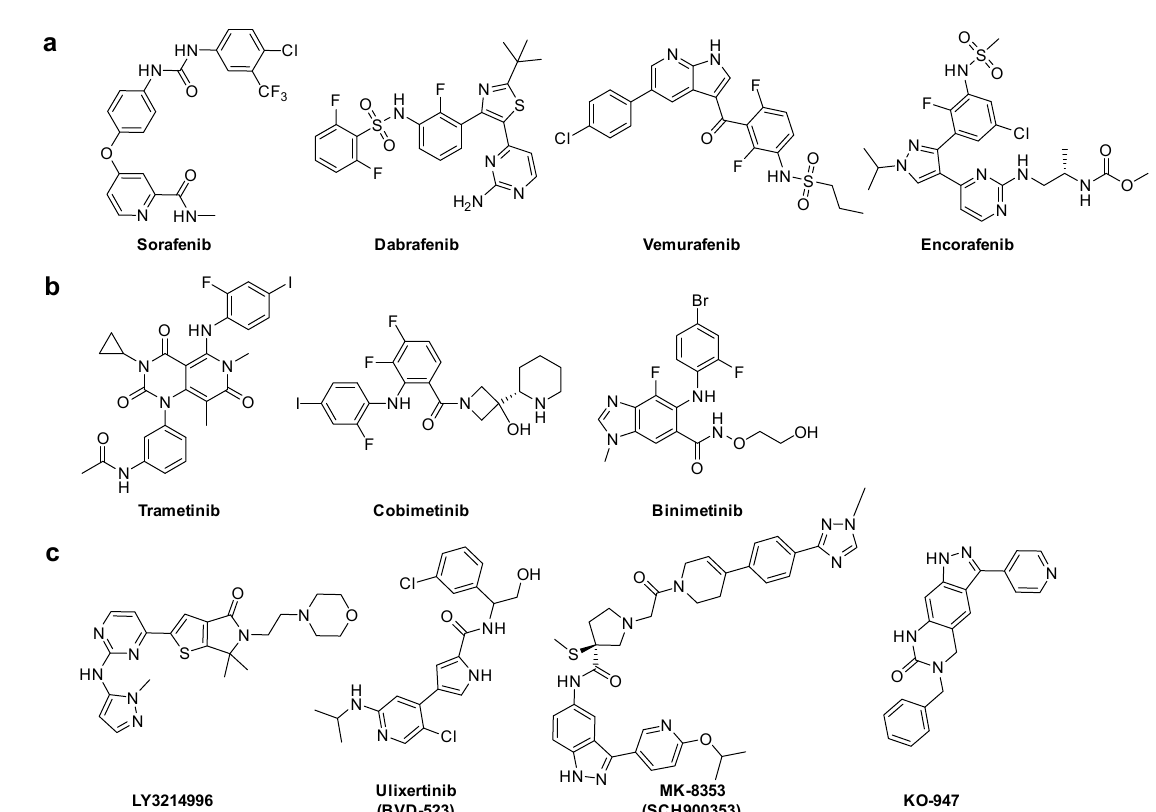
Figure 5. Chemical structures of RAS effector protein inhibitors. ( a ) B-RAF inhibitors. ( b ) MEK inhibitors. ( c ) ERK inhibitors.